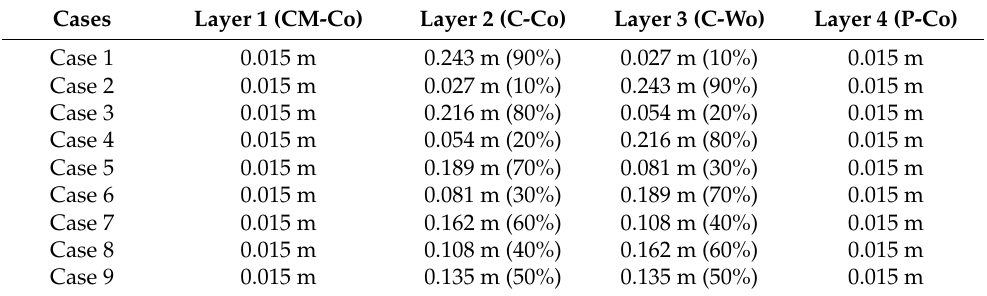
Table 2. Case studies of the thicknesses of the multilayer material with a total thickness of 0.3 m. Cases